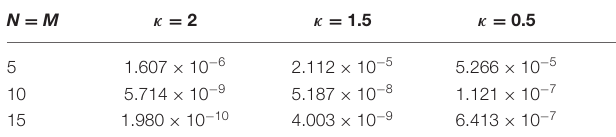
TABLE 3 | Case III: The L ∞ - errors for Example 5.1 vs. κ with γ = η = 0. N = M κ = 2 κ =